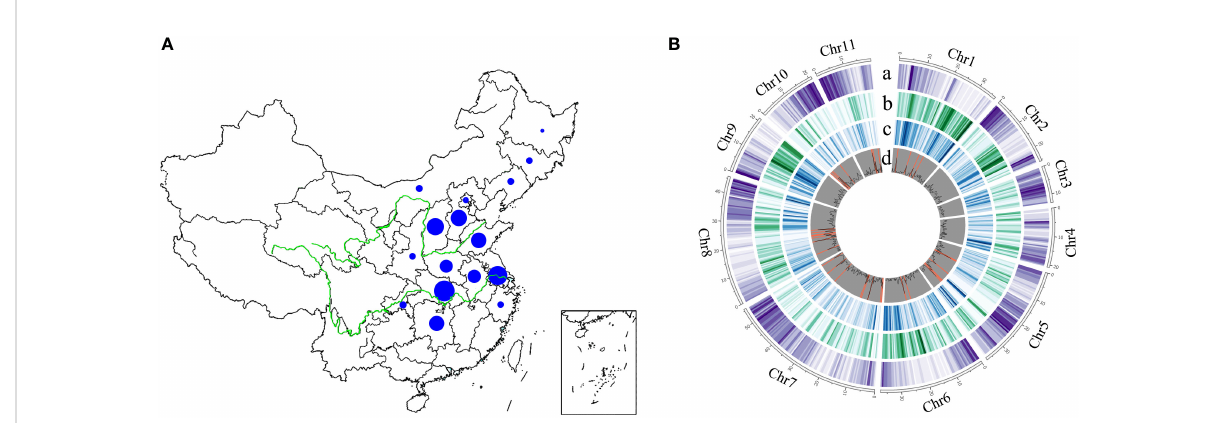
FIGURE 1 The geographical distribution and genome-wide variations of 558 mungbean landraces. The size of the blue pie represents the number of samples. (A) Landraces collected from 16 provinces in China. (B) A total of 2,582,180 high-quality SNPs and 412,999 indels (ranging from 1 to 244 bp in length) were obtained among 558 landraces across the 11 mungbean chromosomes. Track a, Gene density; b, SNP density; c, indel density; d, genomic regions with ratio of non-synonymous to synonymous SNPs > 2.5 (highlighted in